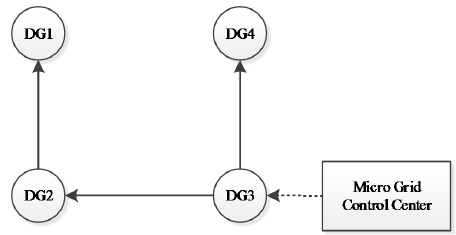
Table 7. Summary of Simulation Results in Scenario II.